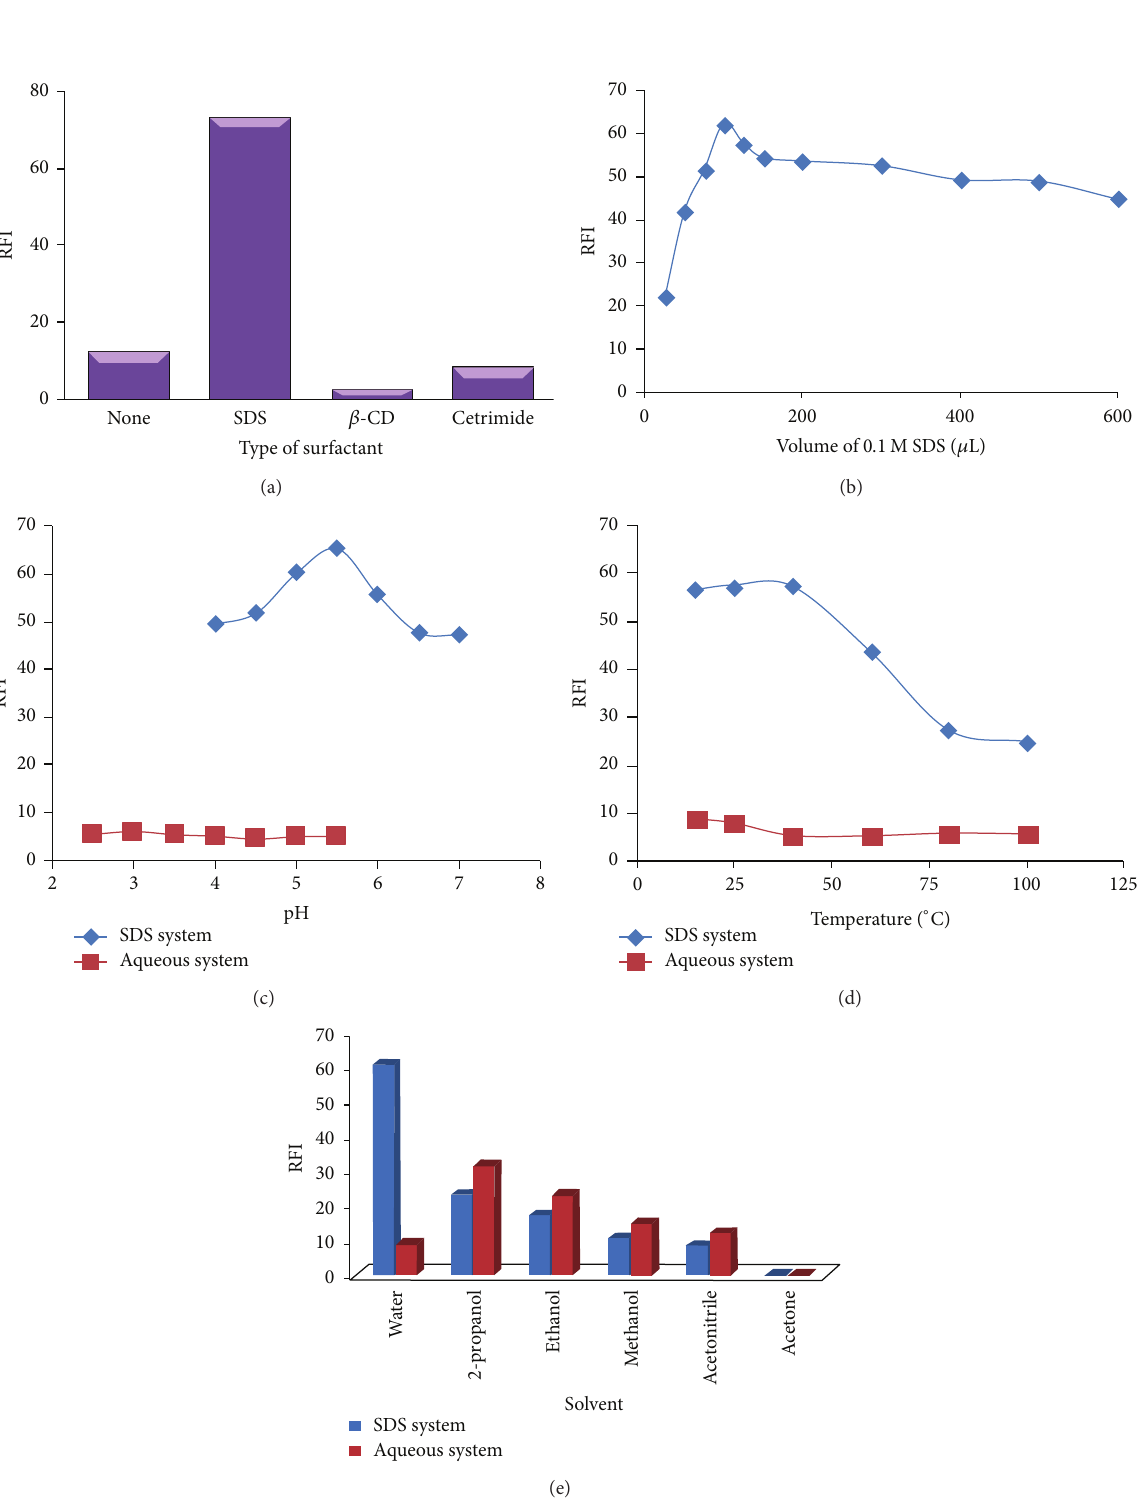
Figure 4: Effect of the different optimization factors. (a) Type of surfactant, (b) concentration of SDS surfactant, (c) pH, (d) temperature, and (e) diluting solvents on RFI using micelle-enhanced spectrofluorometric